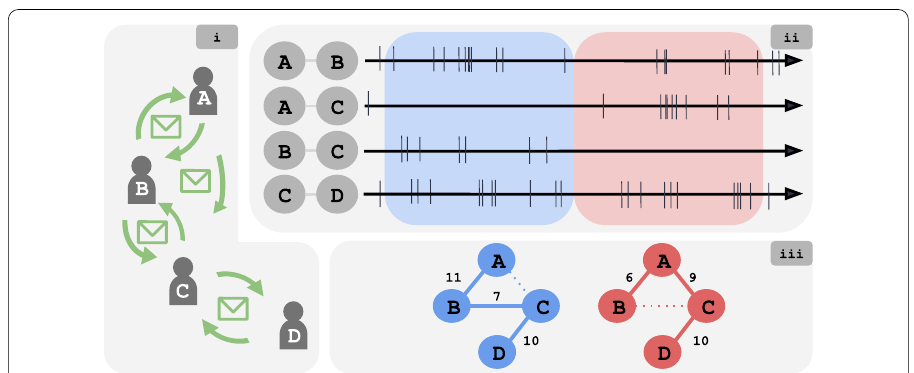
Fig. 1 Network reconstruction from recorded interactions. (i) In a simple social system, individuals A–D contact each other through directed letters, emails, phone calls, etc; (ii) we model undirected interactions as a time series of contact events, reconstructed from recorded contact metadata (sender, receiver, timestamp). Datasets are constrained to observation periods or snapshots (blue and red). (iii) Given an observation period, we can reconstruct a static network by creating links between nodes A–D if we observe at least one contact (solid lines). We do not account for a link if we do not observe data during the observation period (dashed lines). A common technique is to assign a link weight w (numbers) based on the number of